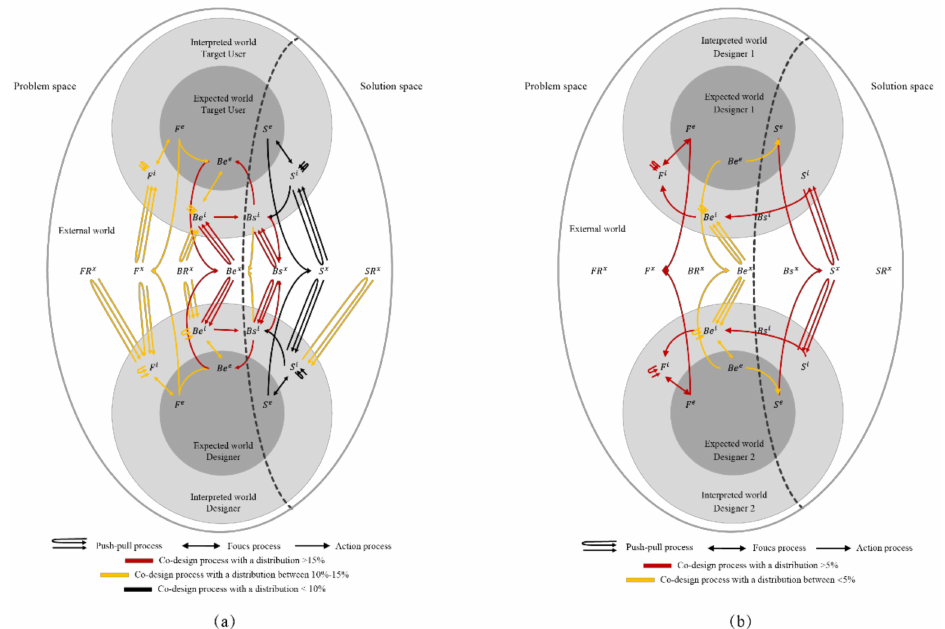
Figure 8. ( a ) Representation of the situated FBS co-design processes between users and designers. ( b ) Representation of the situated FBS co-design processes between